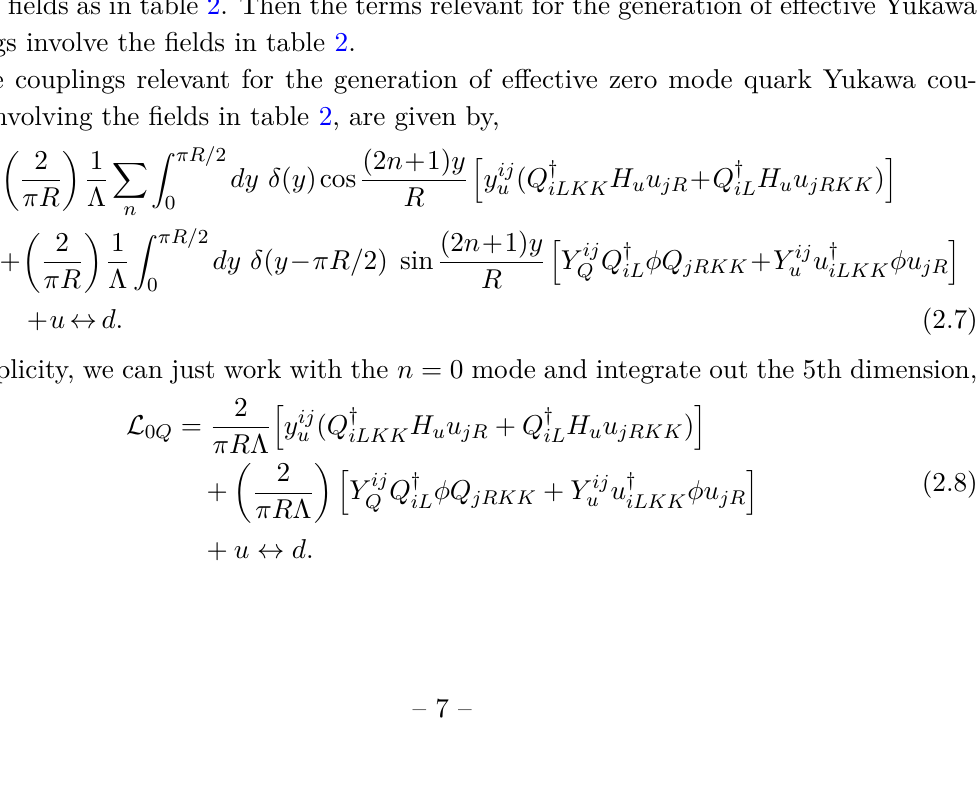
Figure 1 . Fixed branes (locating the Higgs) at y = 0 , πR/ 2 and the normalised wavefunction squared | ψ | 2 profiles for the lowest bulk modes. The H − renamed H u,d in the text. The massless n = 0 modes A 0 correspond to the horizontal black line at | ψ | 2 = 0 . 5 . Their isoneutral n = 1 KK modes have square wavefunctions depicted by the blue curve. Other n = 0 isoneutral modes are massive KK states shown by the brown curve. The n = 0 isocharged square wavefunctions are massive KK modes indicated by the green, red curves which vanish on the branes at y = 0 , πR/ 2 ,